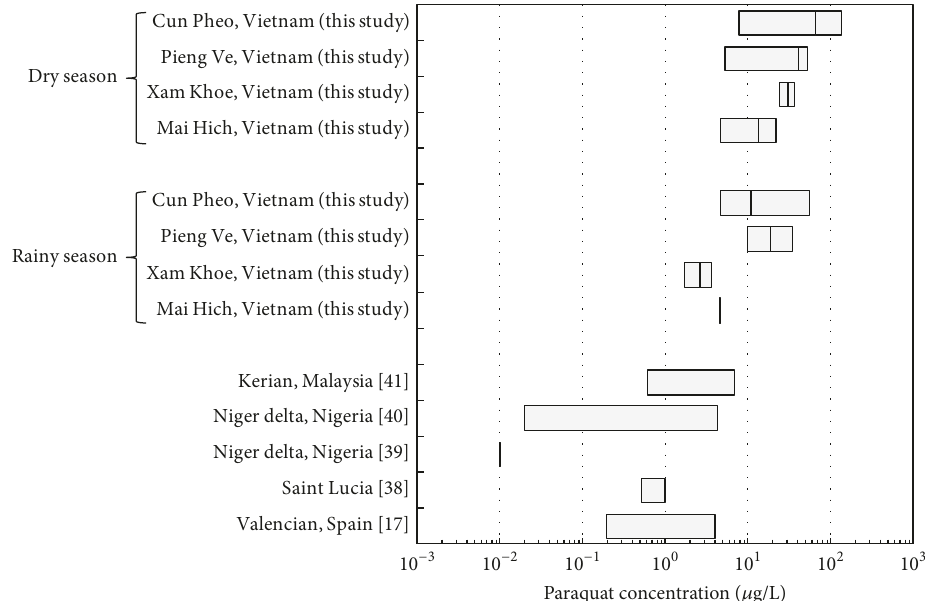
Figure 3: Paraquat concentrations ( 𝜇 g/L) in surface water in paraquat-contaminated areas. Bar and line indicate range and median, respectively.